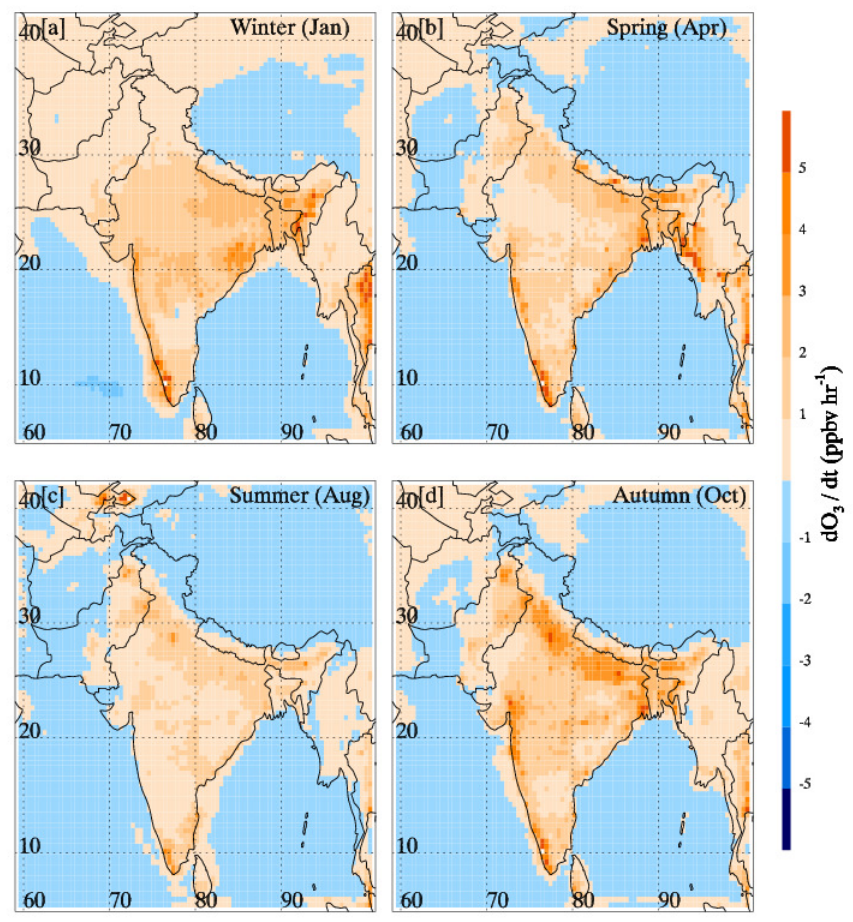
Fig. 19. Spatial distributions of WRF-Chem simulated daytime (11:30–15:30 LT) ozone net production during January, April, August and Figure 19: Spatial distributions of WRF-Chem simulated daytime (1130-1530 LT) ozone net 1362 October production during January, April, August and October 2008. 1363